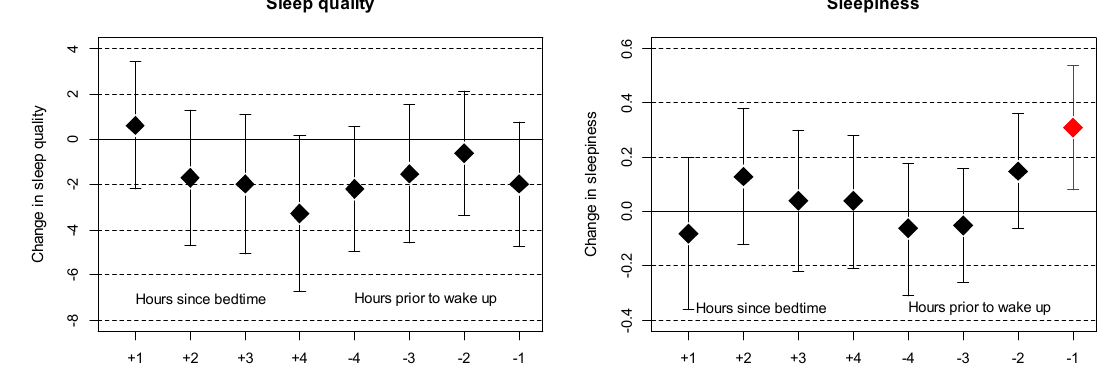
Figure 3. Association between self-reported outcomes recorded each morning in the sleep diary and outdoor noise exposure for each hour after bedtime ( + ) or noise exposure for each hour prior to wake-up ( − ). Changes refer to a 10 dB(A) increase in noise exposure in the respective hour. Same adjustments as indicated in Figure 1.